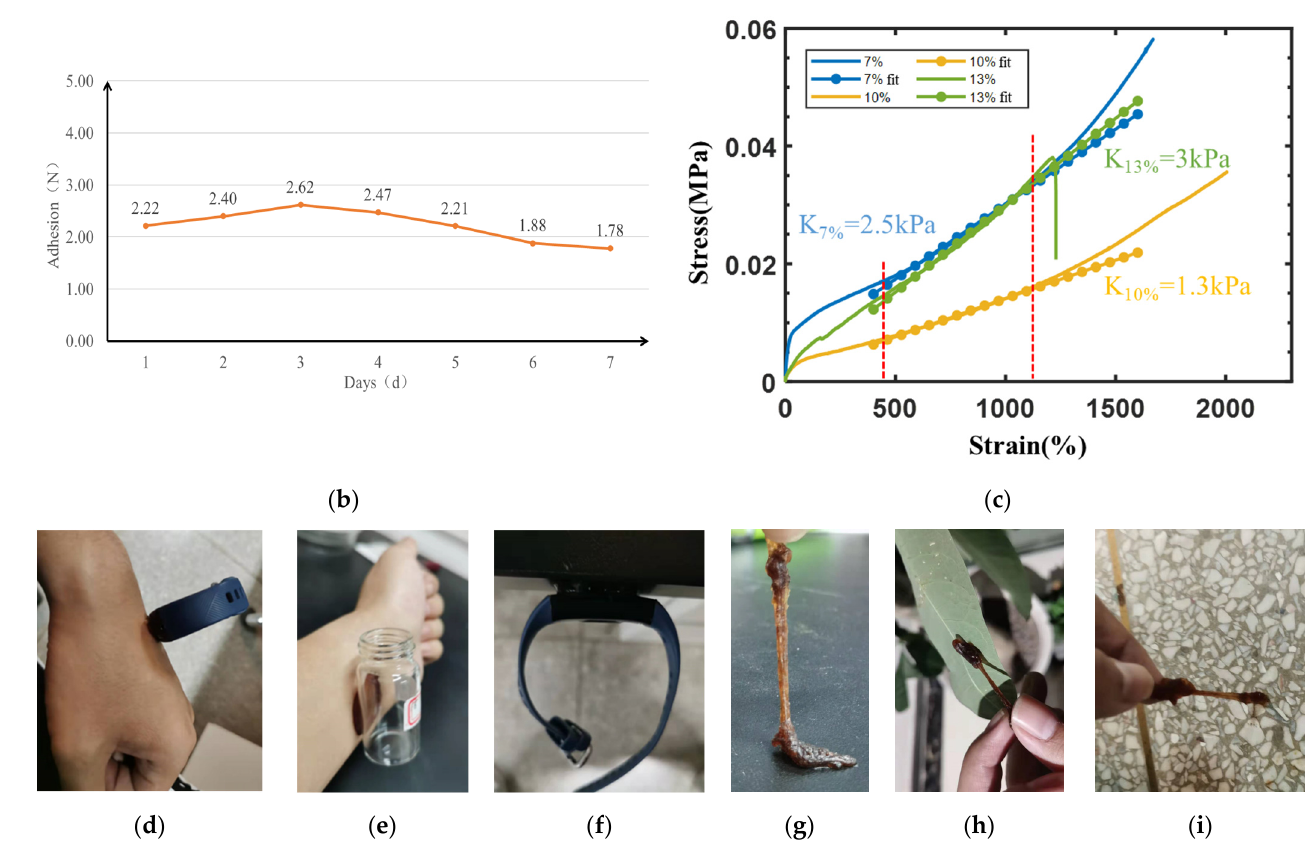
Figure 4. Test results of adhesive property of the biomimetic mussel mucus hydrogel: ( a ) Repeated adhesion; ( b ) Change in adhesion force for seven consecutive days; ( c ) Stress–strain curves of 7%, 10%, and 13% Lap content hydrogels; ( d ) As adhesive of skin surface and sports bracelet; ( e ) As adhesive of skin surface and glass bottle; ( f ) As adhesive of desktop side wall and sport bracelet; ( g ) Adhesion to desktop; ( h ) Adhesion to leaf surface; ( i ) Adhesion to uncleaned floor.